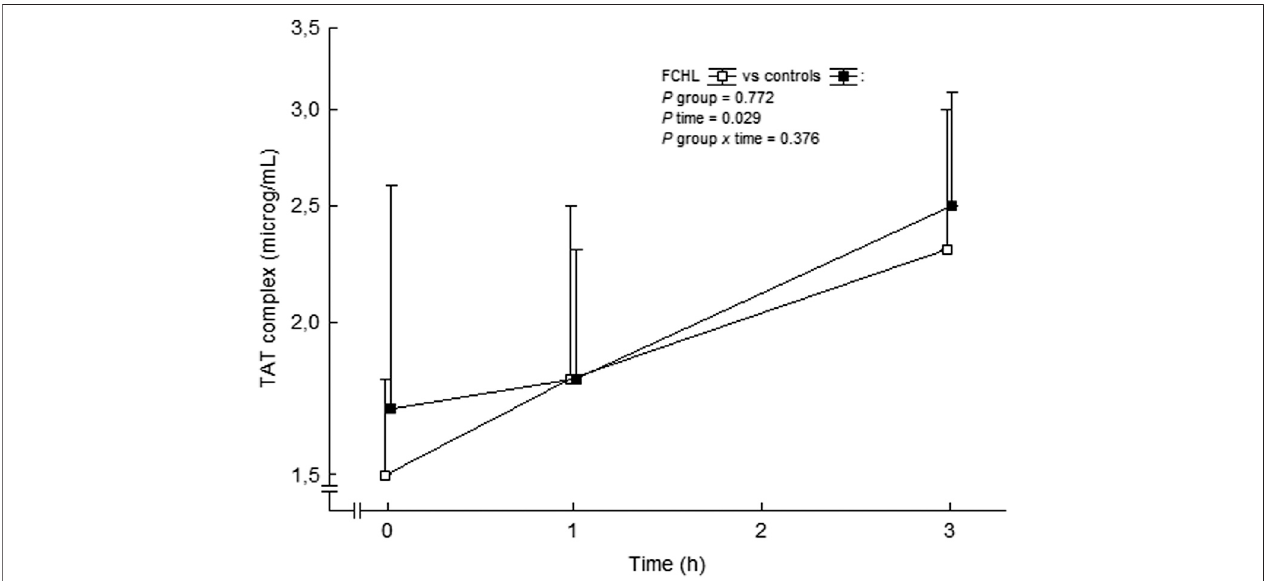
FIGURE7| TATcomplex inplasmabeforeand during the ongoing angiotensin IIinfusion. Dataarepresentedasmedian values andinterquartile ranges. Statistical evaluation was made by repeated measures ANOVA. TAT, thrombin-antithrombin and FCHL, familial combined hyperlipidemia. FCHL □ ( n (cid:1) 16) and FCHL-control ■ ( n (cid:1) 16). From (Ekholm et al.,